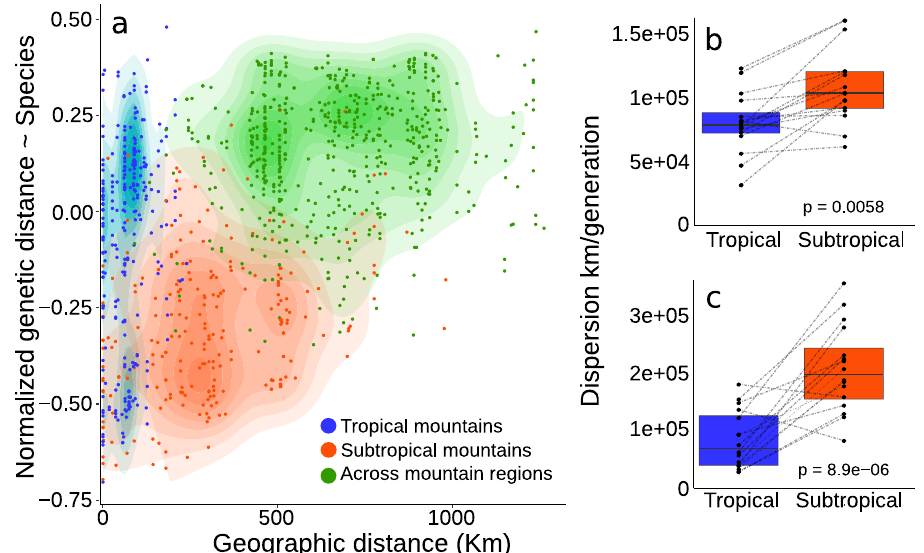
Fig. 4 Patterns of association between genetic and geographic distances among tropical and subtropical populations. a Plot of the residuals of a linear model between the normalized Euclidean genetic distance and species, as a function of geographic distance for 21 species of birds restricted to the Atlantic Forest sky islands (regression line: p value <0.0001; R 2 = 0.32). Colors represent pairwise comparisons within and between mountain regions and color gradients represent the density of points. Geographic distance in kilometers (Km) Effective dispersal in meters per generation for populations occurring in the tropical and subtropical mountains of the Atlantic Forest obtained with the Bidimensional Stepping Stone Model (BSSM); b Migrations between localities were scaled by the linear spatial distances ( n = 16 species pairs); c Migrations were not scaled by distances (see Methods for more details) ( n = 16 species pairs). The boxplots are composed of the median (center), the fi rst and third quartiles (lower and upper hinges), and the 1.5 * IQR from the hinge (where IQR is the interquartile range; upper and lower whiskers). Lines connect populations of the same species. p = P value obtained with a two- sided nonparametric Wilcoxon test. Source data are provided in Supplementary Tables 5 and 6. Table 1 Support for alternative models of connectivity across the Atlantic Forest mountains from Maximum Likelihood population effect